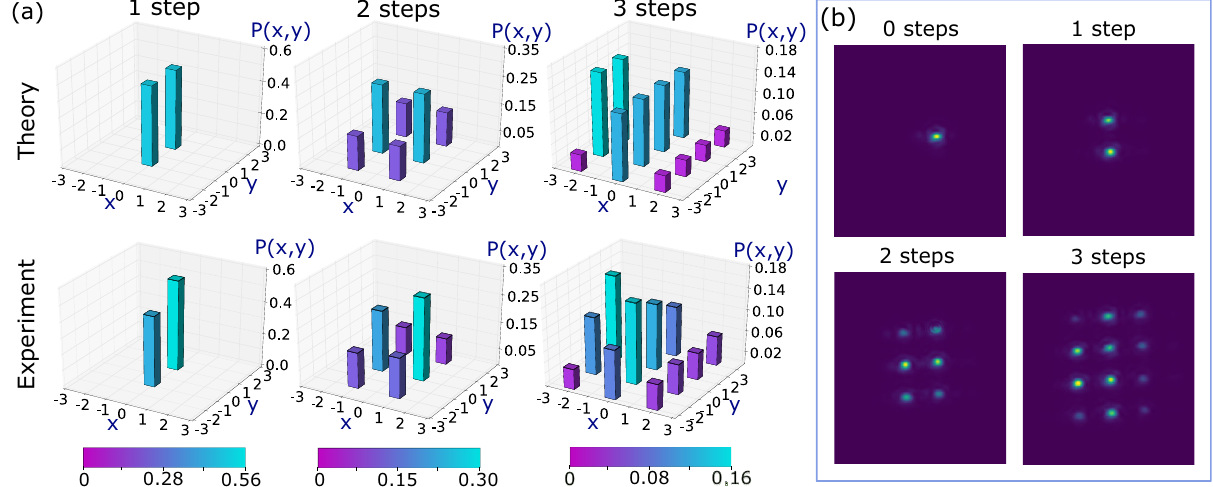
Fig. 4 Single-photon 2D quantum walk. a Experimental distribution of one-particle quantum walk performed with single-photon input, in comparison with theoretical predictions after each step. Data were collected using single-photon detectors. The initial position of the walker is (1, 0) and the initial polarization is D j i . Shaded regions on top of each bar correspond to the experimental error at 1 standard deviation. The error bars were obtained through a bootstrapping approach. b Images reconstructed with a CCD camera with classical light inputs on the same site and with the same